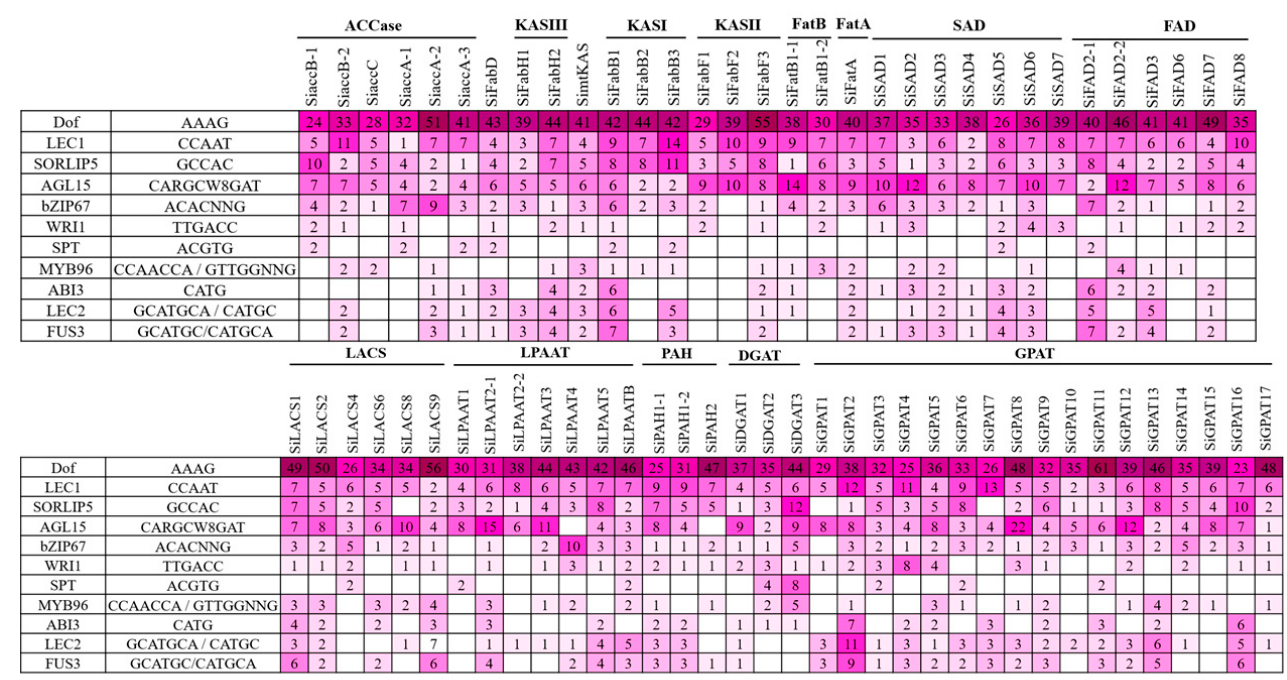
Figure 3. Distribution of cis -acting regulatory elements (CAREs) in the promoters of selected genes detected in the PlantCare tool.